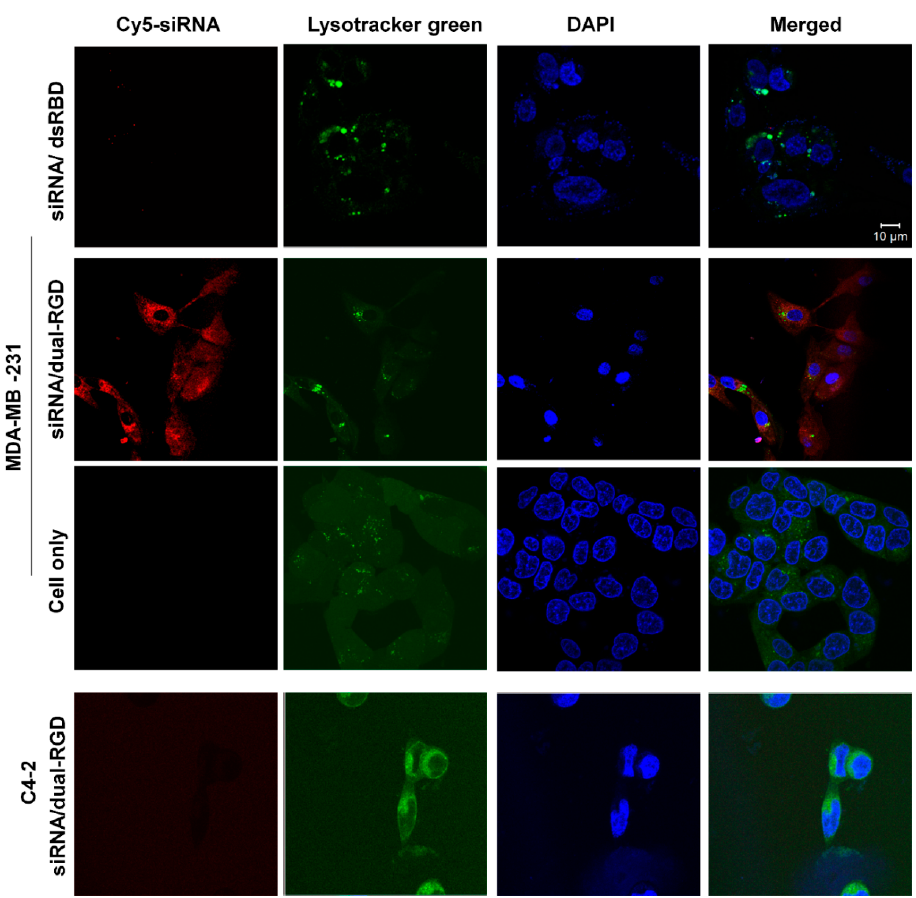
Figure 4. Detection of dual-RGD/Cy5-siRNA internalization by confocal microscopy. The complexes of Cy5-siRNA/dual-RGD were incubated with MDA-MB-231 (integrin α v β 3 positive) and C4-2 cells (integrin α v β 3 negative), and Cy5-siRNA complexed with dsRBD-18H without RGD as a protein control were incubated with MDA-MB-231 cells. LysoTracker Green (green) was used to show endosomes and lysosomes, and DAPI (blue) was used to display the nucleus. Confocal laser scanning microscopy images were acquired after treatment. Scale bar, 10 µ